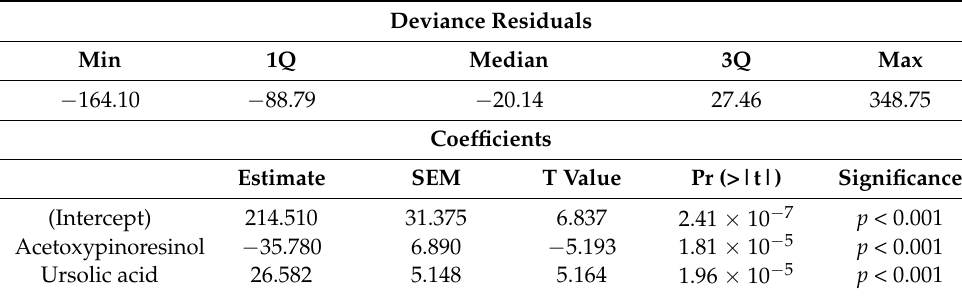
Table 4. GLM 3 summary (antiproliferative capacity,